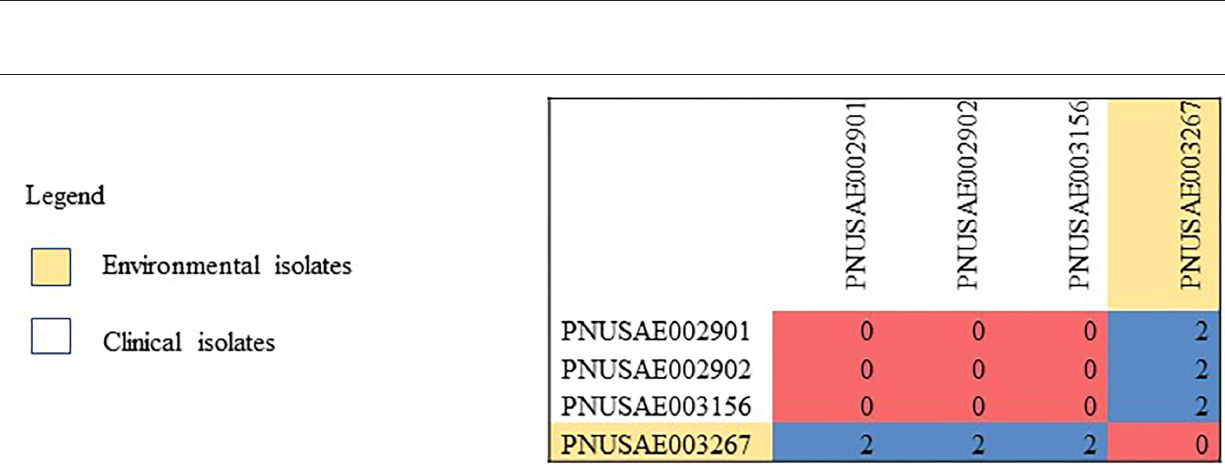
Frontiers in Veterinary Science |